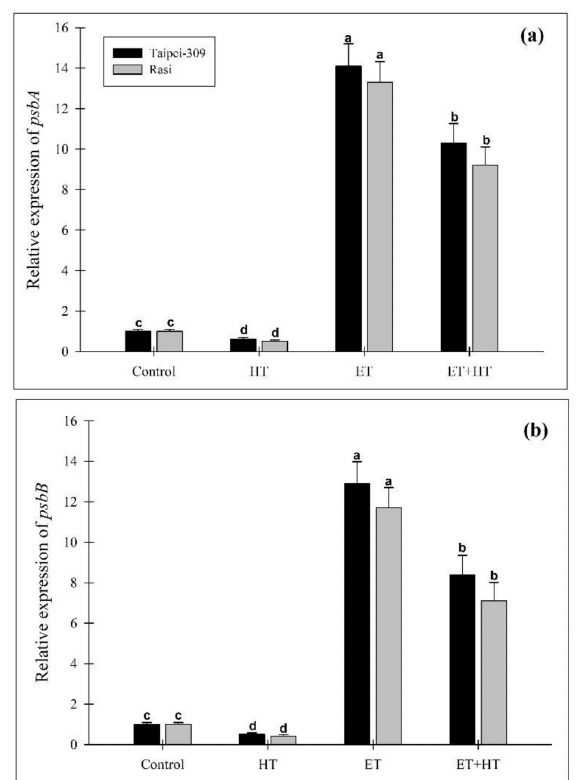
Figure 6. Relative expression of the genes psbA ( a ) and psbB ( b ) in leaves of Taipei-309 and Rasi cultivars of rice ( Oryza sativa L.) at 30 DAS. Plants were grown with/without high-temperature (HT) stress and treated with a foliar spray of 1.60 mM ethephon (ET) at 15 DAS. Data are presented as treatment means ± SE ( n = 4). Bars with the same letters did not differ significantly by the LSD test at p < 0.05. DAS, days after